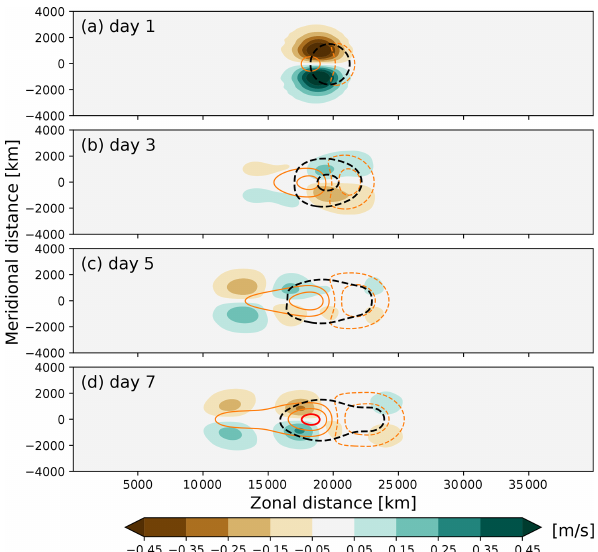
Figure A2. The same as Fig. 11 but for homogeneous-density PE instead of full PE.